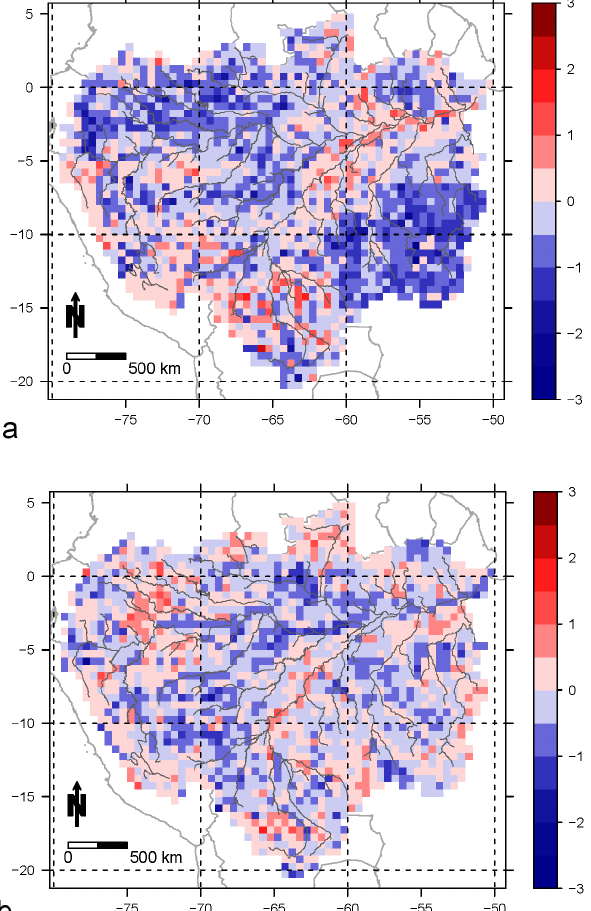
Fig. 10. Difference in the probability of at least three consecutive Figure 10. Difference in the probability of at least three consecutive extremely dry 862 extremely dry years (a) and extremely wet years (b) between the future and reference years (a) and extremely wet years (b) between the future and reference period. 863